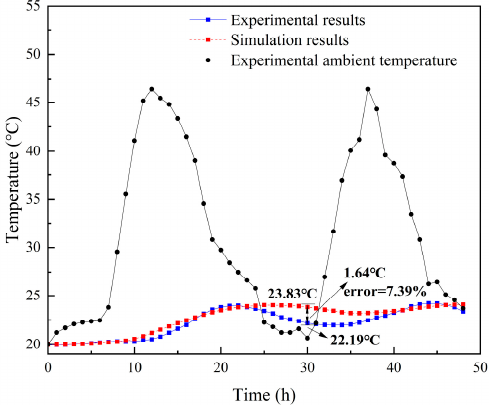
Figure 8. The comparison between the experiment and calculated